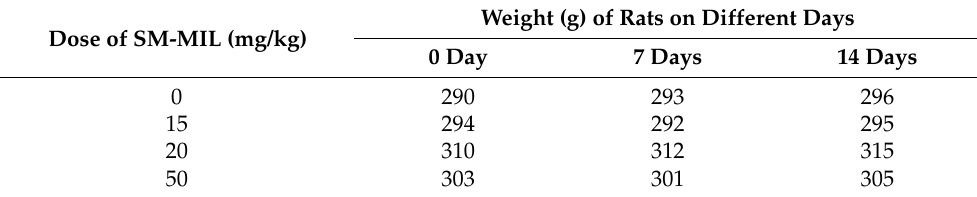
Table 3. Haematological parameters of the rats treated with SM-MIL for 7 and 14 days, respectively.